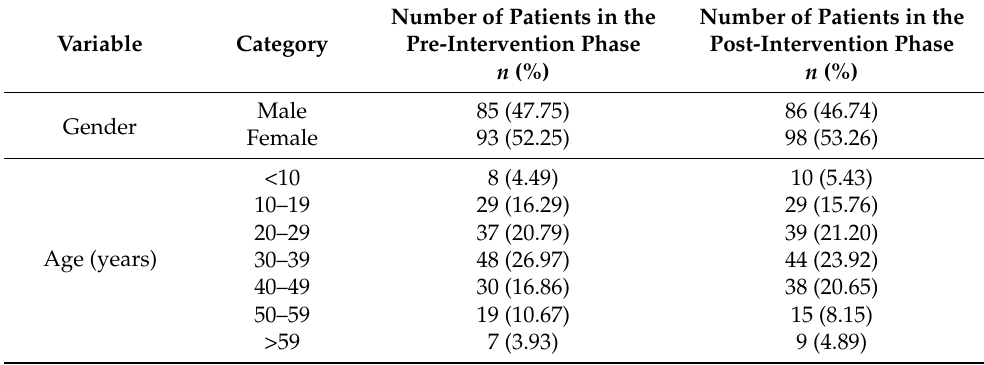
Table 1. Patients who underwent gastrointestinal surgery before and after the intervention. Number of Patients in Variable Category